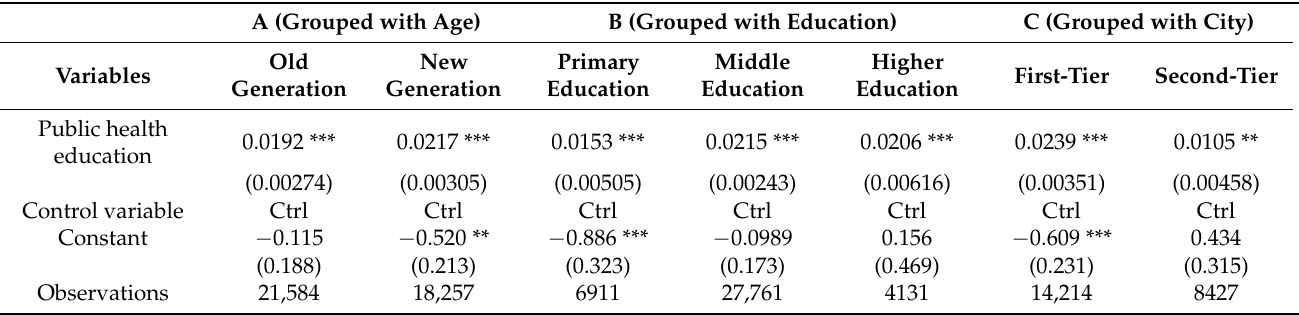
Table 4. Heterogeneity of public health education on medical service utilization of different migrant